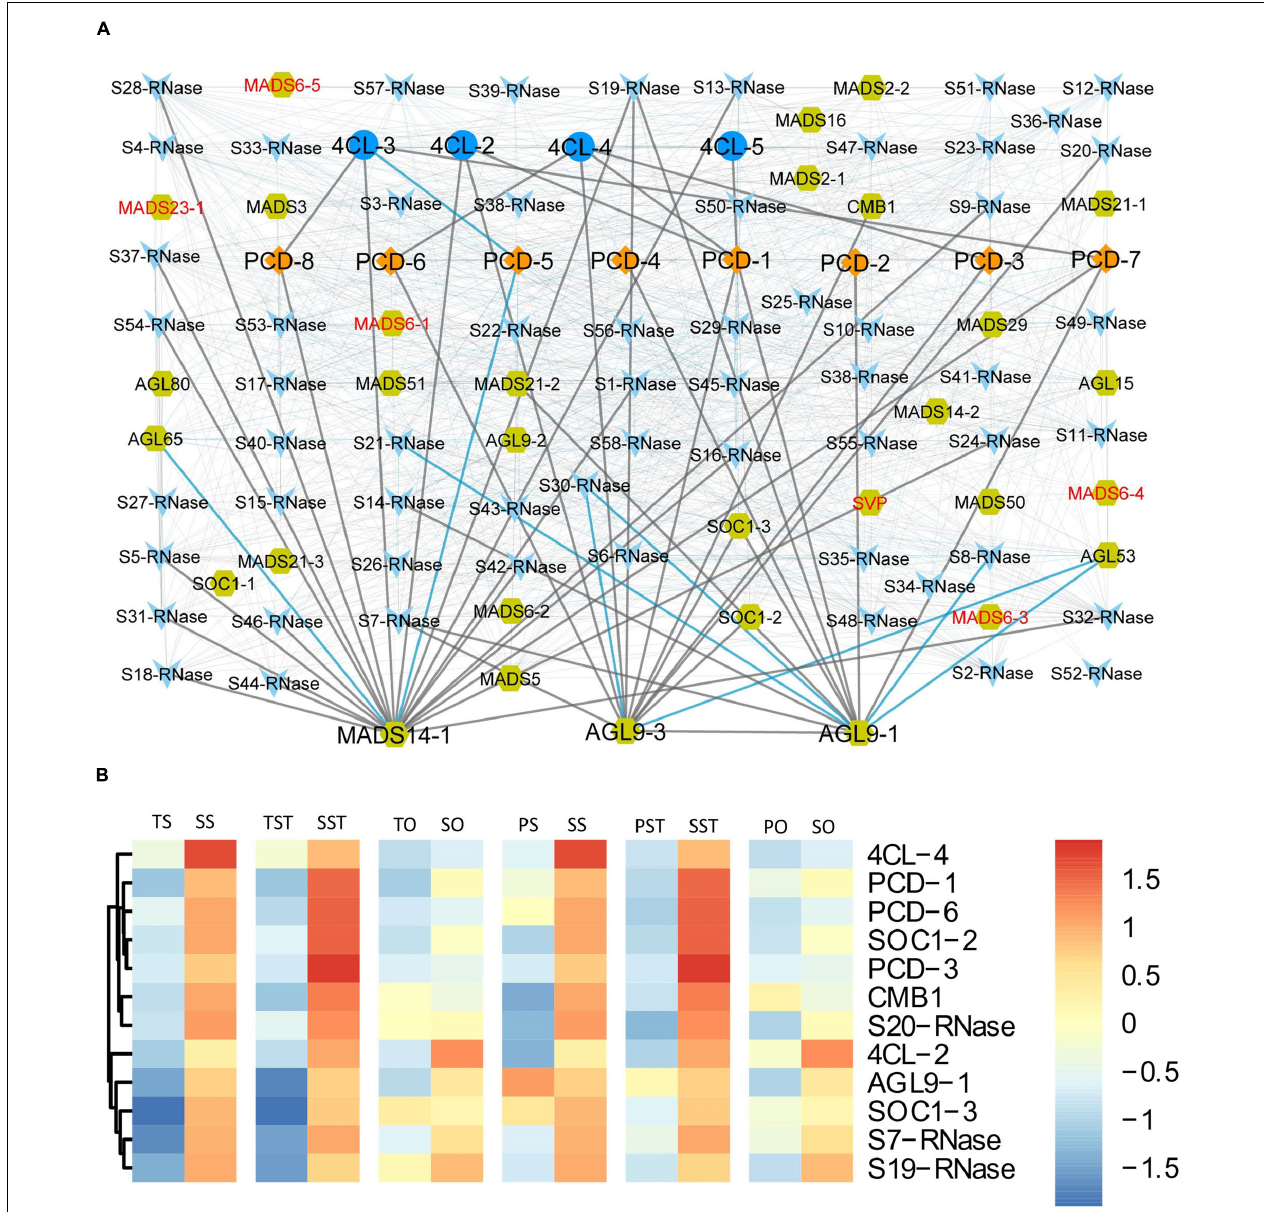
FIGURE 10 | Analysis of potential cooperation among PCD genes (PCD1–PCD8) and three groups of PCD-related genes: 4CL, S-RNase, and MADS-box (A) Co-expression network of genes. Red texts indicate MADS-box genes which were specifically down-regulated in the ovary of Seedless palm trees compared with Tenera and Pisifera. Gray edges linking nodes represent positive correlation while blue edges represent a negative correlation. Nodes: PCD, diamond; 4CL, ellipse; S-RNase, V-shaped; MADS-box, hexagon. (B) Heatmap showing the expression patterns of genes positively correlated with AGL9-3